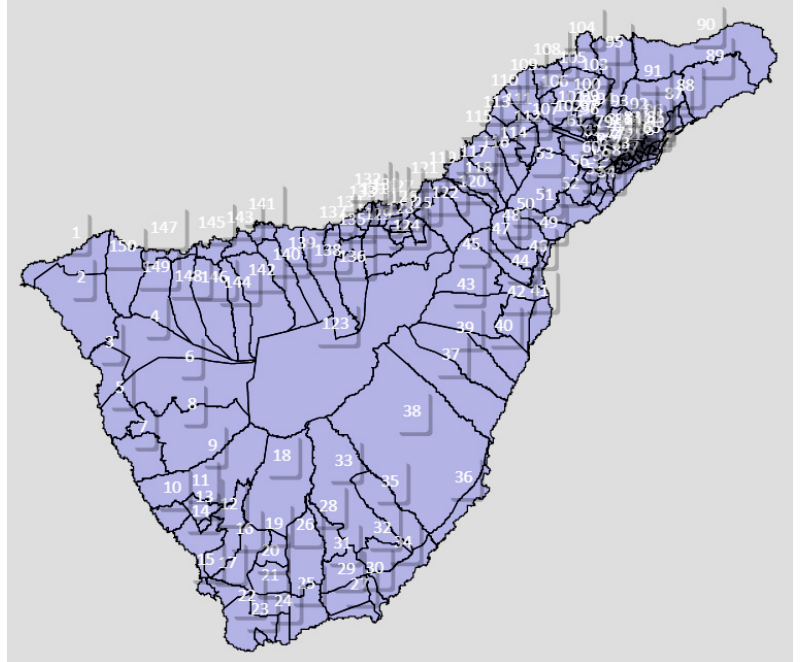
Figure 8. Numerically ordered transport zones into which Tenerife has been divided in the mobility study.